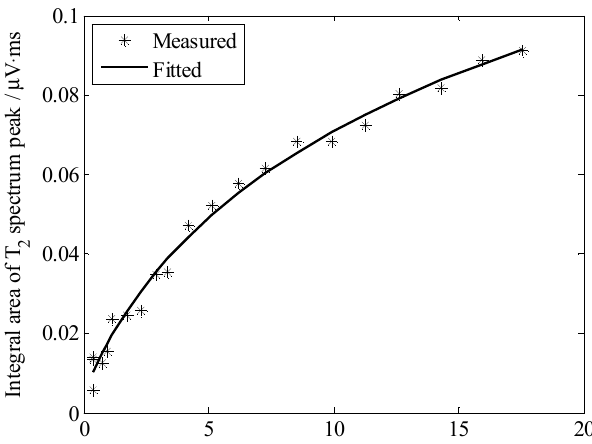
Figure 11. T 2 spectrum curves of the sandy soil with different moisture content.